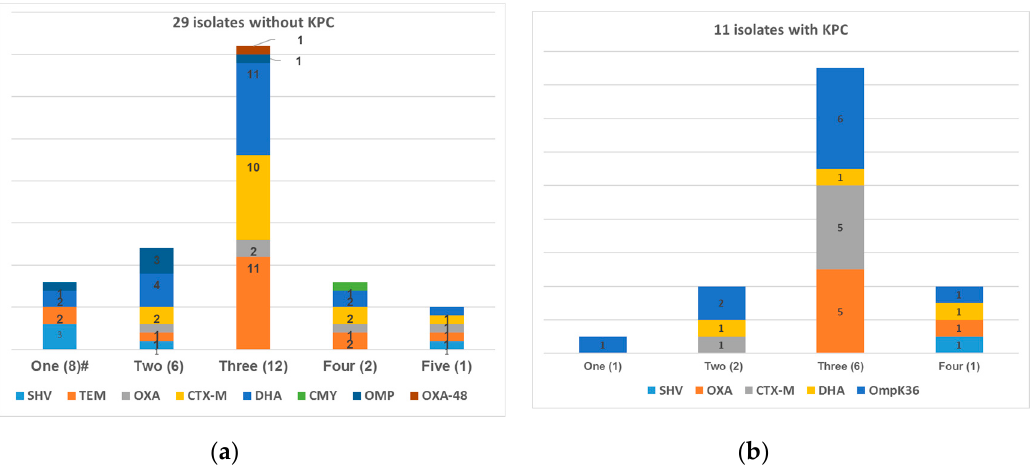
Figure 1. Distribution of the examined resistance mechanisms among the 40 isolates. ( a ) non-KPC producers; #, number of simultaneous resistance mechanisms (number of isolates) ( b ) KPC producers, with one isolate lacking data for outer membrane proteins.